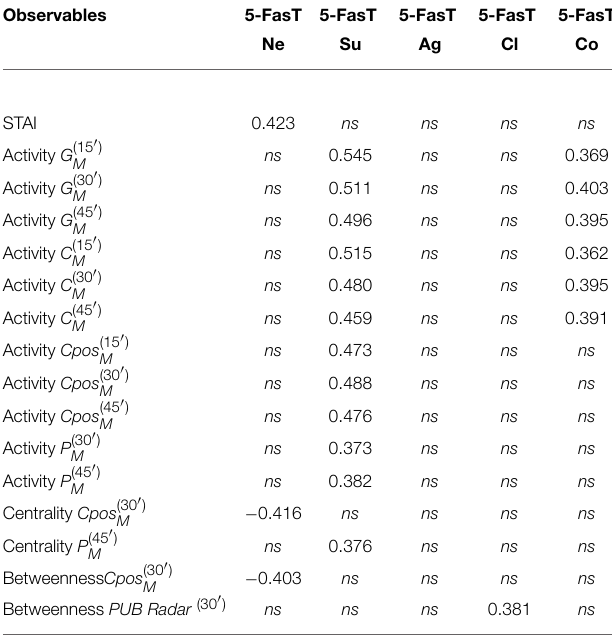
TABLE 4 | Significant correlations between the 5-FasT personality factors and the communicative